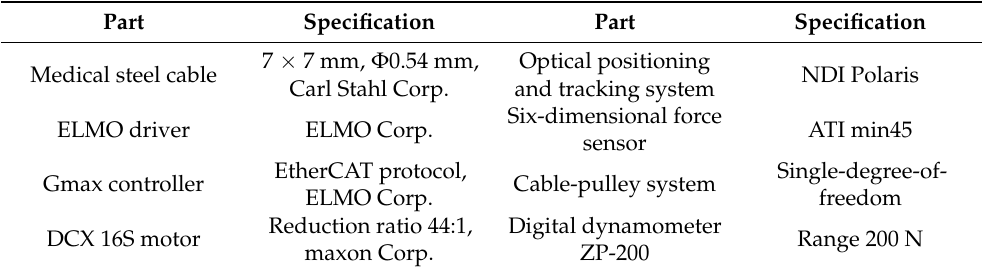
Table 1. The specific description of the device used in the dedicated experimental platform. Part Specification Part Specification 7 × 7 mm, Φ 0.54 mm, Optical positioning NDI Polaris Medical steel cable Carl Stahl Corp. and tracking system Six-dimensional force ATI min45 ELMO driver ELMO Corp. sensor Single-degree-of- EtherCAT protocol, Cable-pulley system Gmax controller freedom ELMO Corp. Reduction ratio 44:1, Digital dynamometer DCX 16S motor maxon Corp. ZP-200